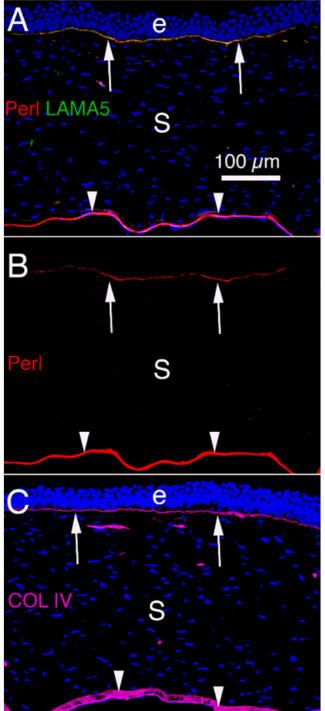
Figure 2. Corneal BM components that modulate TGF beta-driven myofibroblast development and fibrosis in unwounded rabbit corneas [5]. ( A ) Immunohistochemistry (IHC) for perlecan (Perl), as well as laminin alpha-5 (LAMA5) [5]. ( B ) IHC for perlecan alone. ( C ) IHC for collagen type IV. Arrows indicate the EBM with overlying epithelium (e) and arrowheads indicate Descemet’s membrane that overlies the corneal endothelium, respectively, in all panels. S is stroma populated primarily with keratocytes. Blue is DAPI stained nuclei. Mag. 200 ×